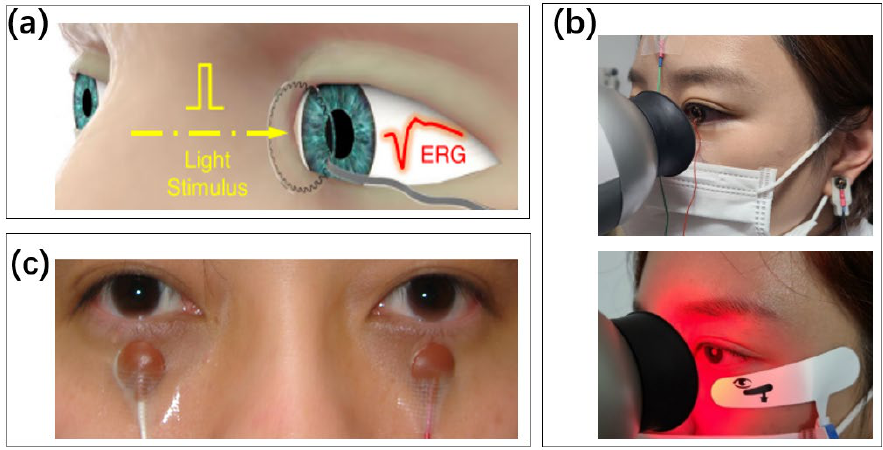
Figure 9. ( a ) Schematic diagram of ERG sensing [114]. The retina produces an electrical signal when light enters the human eye. A wire needs to be introduced to the surface of the eye to read the signal. Reproduced under the terms of the CC-BY Creative Commons Attribution License, Copyright 2021 by the authors, published by Springer Nature. ( b ) Conventional ERG monitoring requires leads from the surface of the eye, making it difficult to use for long periods of time. The new sensing method allows ERG signals to be collected on the skin around the eye, and all-night monitoring is possible [115]. Reproduced under the CC-BY-NC License, Copyright 2021 by the Korean Ophthalmological Society, published by Korean Ophthalmological Society. ( c ) A skin electrode was placed on the lower lid of each eye. The contralateral eye was not covered. A gold-cup electrode was placed on the right earlobe as the ground electrode [116]. Reproduced under the Creative Commons Attribution